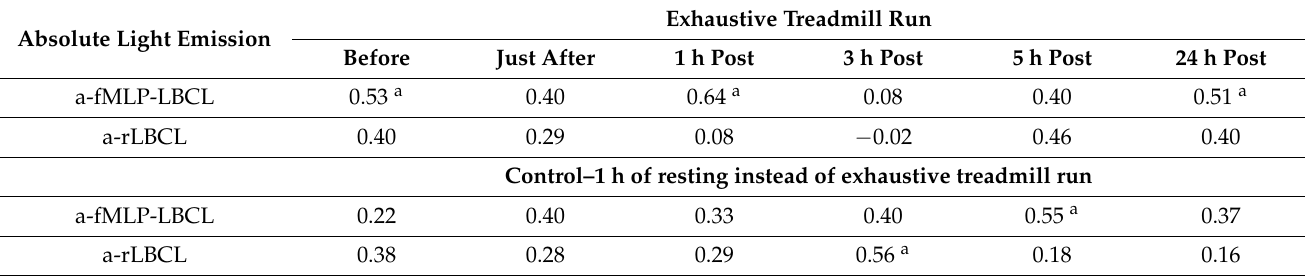
Table 8. Correlations ( δ ) between absolute rLBCL and fMLP-LBCL and the total number of phagocytes (granulocytes and monocytes) in the assayed blood sample collected before, just after and at 1 h, 3 h, 5 h and 24 h post-exhaustive treadmill